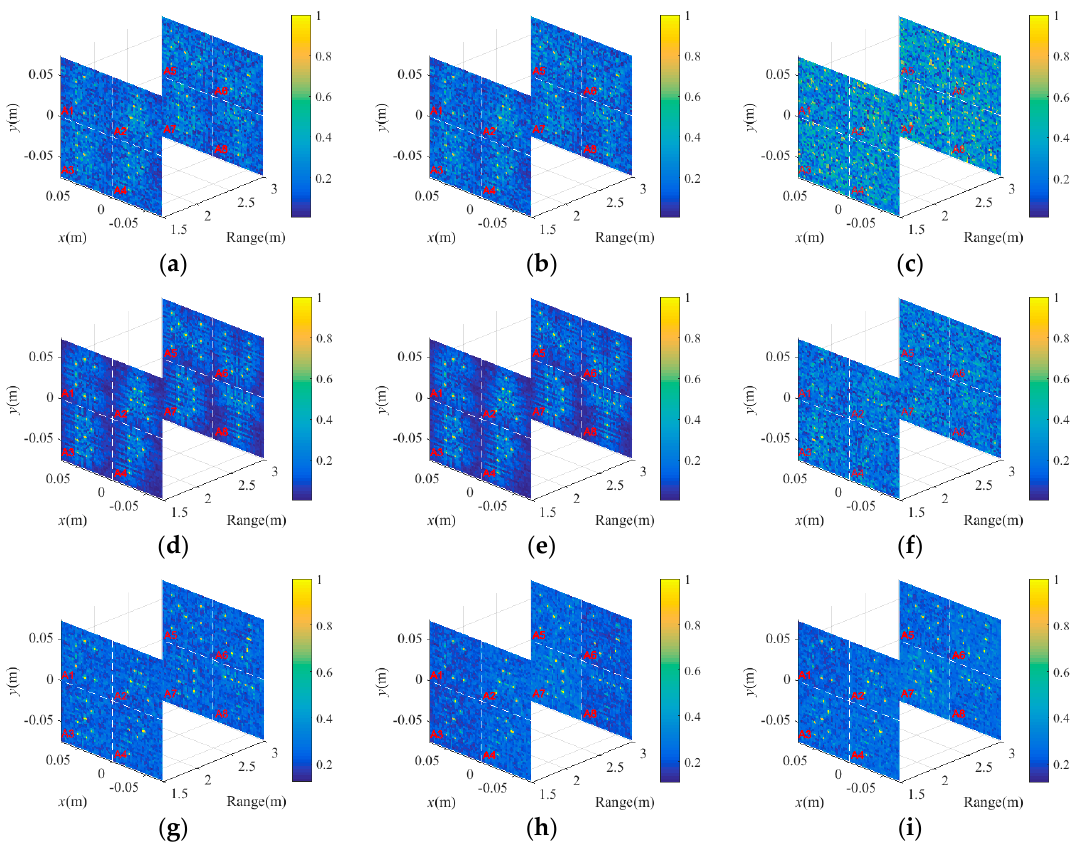
Figure 7. The BP projection results with [ − 0.5 π , 0.5 π ] phase modulation under ( a ) 30 dB, ( b ) 0 dB and ( c ) − 30 dB, respectively. The BP projection results without modulation under ( d ) 30 dB, ( e ) 0 dB and ( f ) − 30 dB, respectively. The GM enhanced BP projection results with [ − 0.5 π , 0.5 π ] phase modulation under ( g ) 30 dB, ( h ) 0 dB and ( i ) − 30 dB, respectively. The “C,” “A,” “B” and “P” shape targets are distributed in R1, while “N,” “U,” “D” and “T” shape targets are located in R2. The “CABP” and “NUDT” denote coded aperture using BP and National University of Defense Technology,